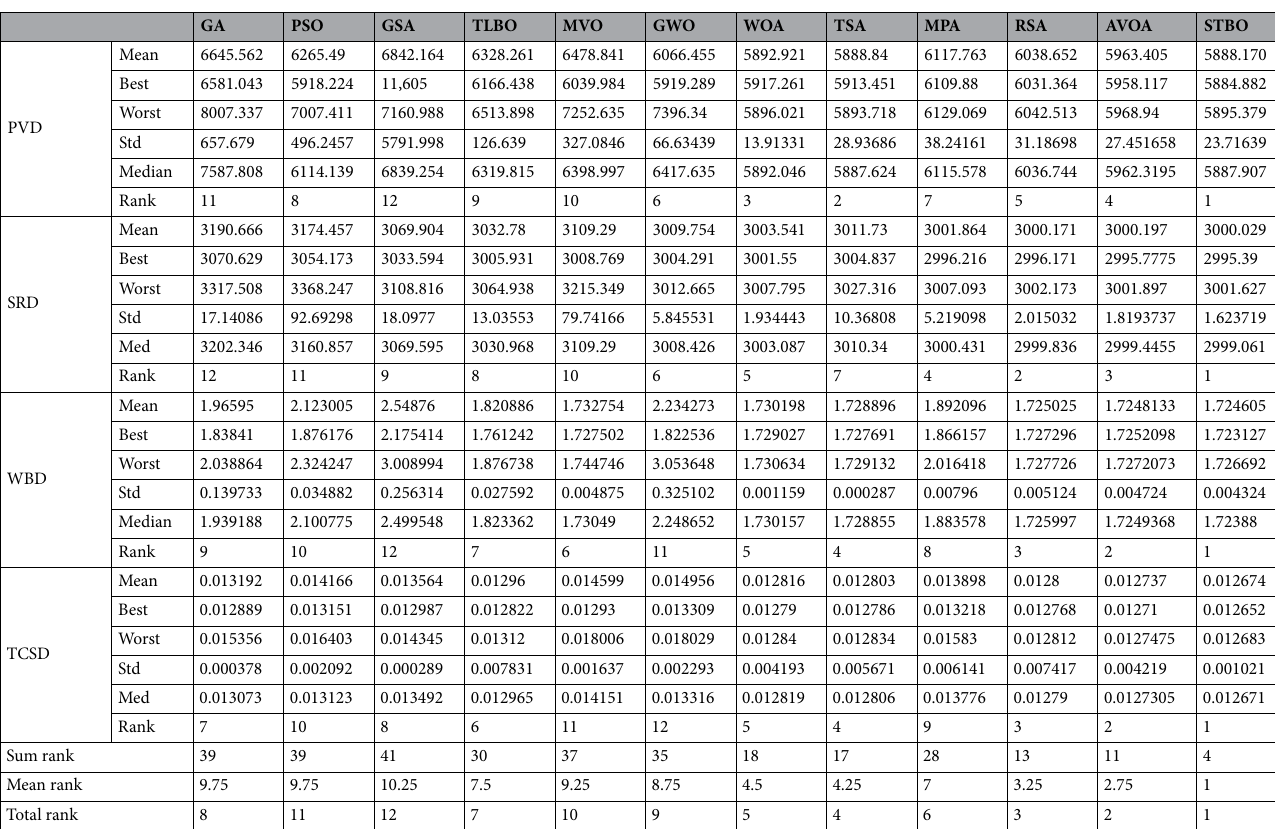
Table 9. Evaluation results of four real-world